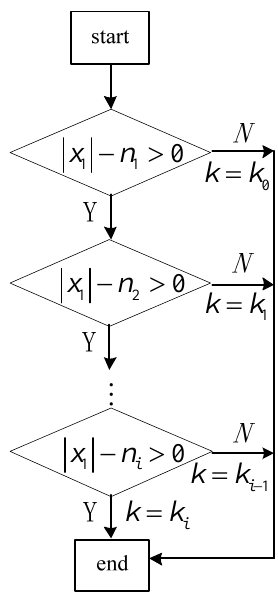
Figure 3. Flow chart of variable k .